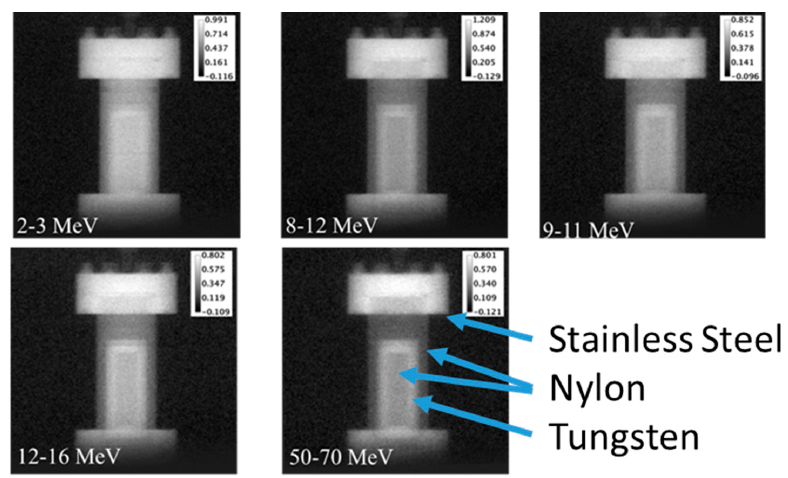
Figure 21. Images from 4FP-60R for multiple neutron energy slices, showing the effects on contrast and resolution as the neutron energy bin width (8–12 vs. 9–11 MeV) and energy are changed from 2.5 to 60 MeV. The assembly shown is about 16 cm tall.